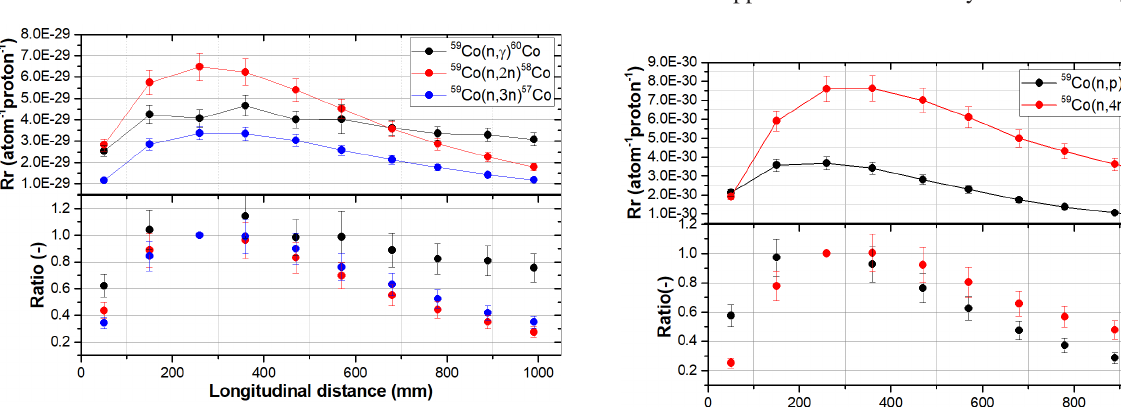
Figure 2. Determination and comparison of 59 Co ( n ,γ ) 60 Co , 59 Co ( n , 2 n ) 58 Co , and 59 Co ( n , 3 n ) 57 Co reaction rates at carbon ex- Figure 1. Scheme of the Carbon target with locations of the experimental samples. periment.